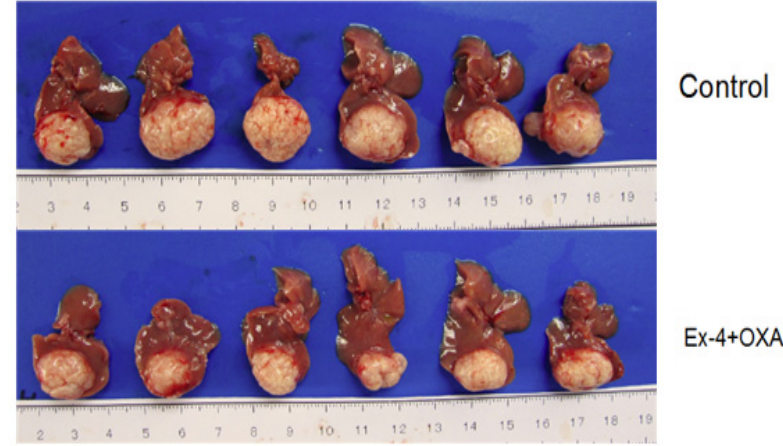
Figure 9. Tumor size in different groups.